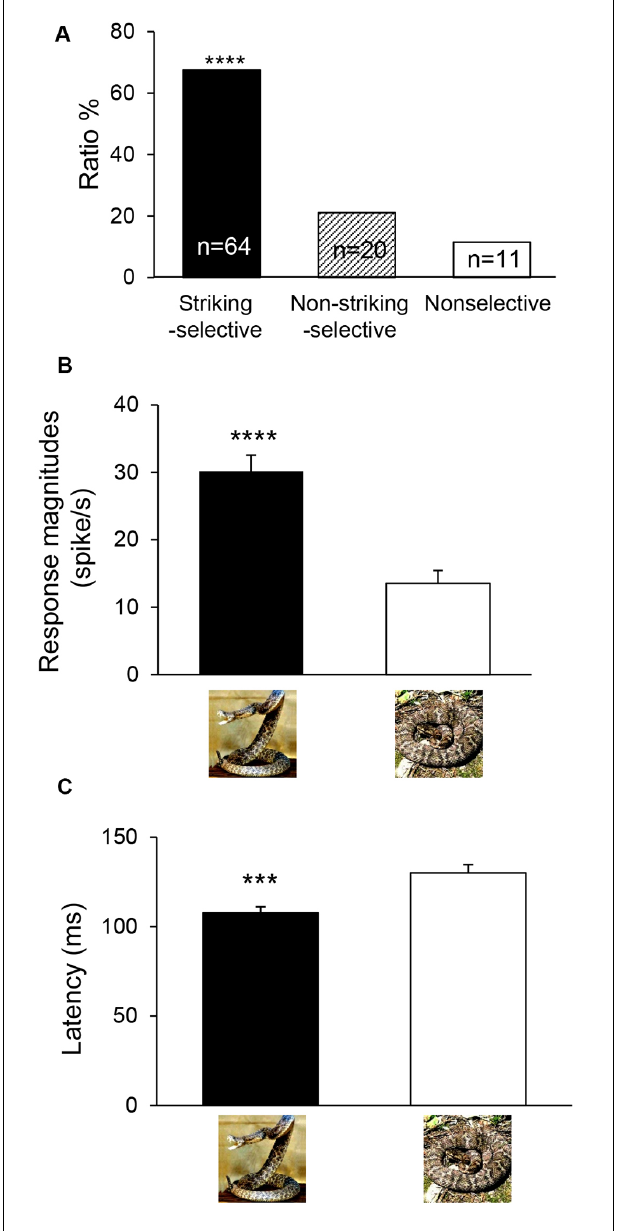
FIGURE 3 | Classification (A) and response characteristics (B,C) of snake-responsive neurons. (A) The ratios of three types of mPFC neurons to the snake postures. ****Significant difference from non-striking-selective mPFC neurons ( p < 0.0001). (B) Comparison of mean response magnitudes to snakes with striking postures and those to non-striking postures ( n = 95). ****Significant difference from snakes with non-striking postures ( p < 0.0001). (C) Comparison of mean response latencies to snakes with striking postures and those to non-striking postures ( n = 87). ***Significant difference from snakes with non-striking postures ( p <